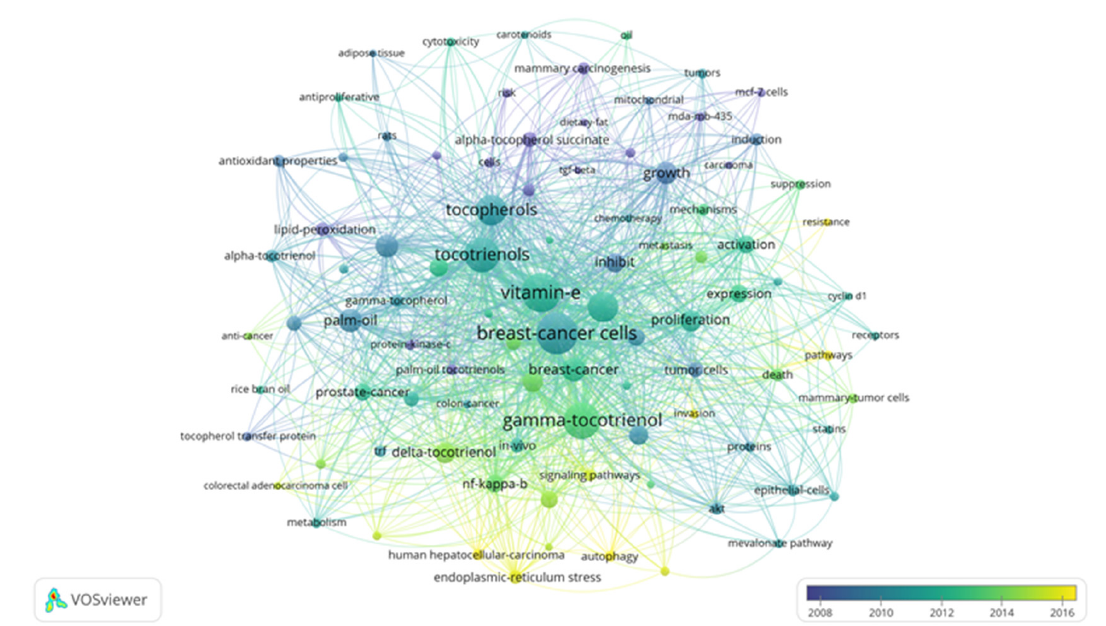
Figure 3. Term map for years 2008–2016 generated from Search 1. Visualization of 96 terms that occurred a minimum of 5 times in publications. Table S2 lists the visualized terms and their respective occurrences, average year of publication, and average number of citations.